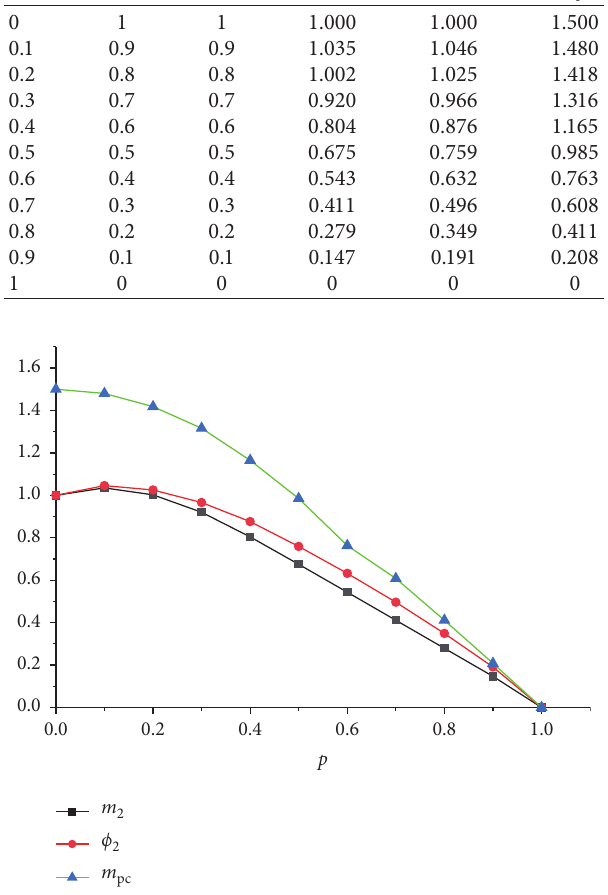
Figure 13: Correlation curves between (m) column